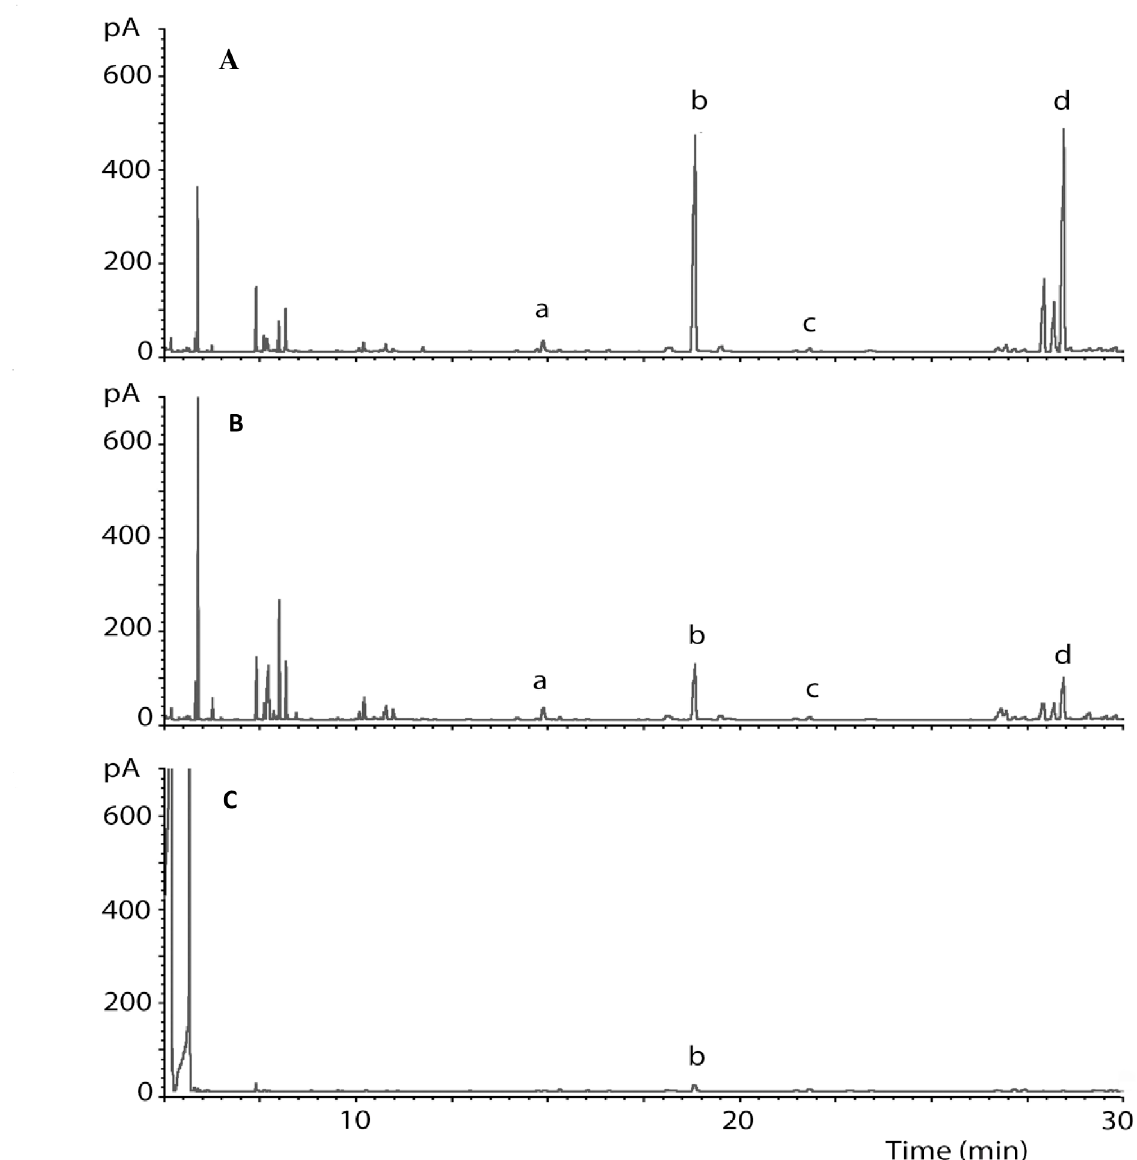
Fig 4. GC profiles of headspace volatiles from maize landrace, ‘ Nyamula ’ : ( A ) exposed to oviposition, ( B ) exposed to egg-induced maize volatiles from neighbouring plant, ( C ) unexposed. The identities of some of the EAG-activec ompounds whose emission was highly elevated by oviposition and induction are as follows: (a) limonene; (b) ( E )-4,8-dimethyl-1,3,7, nonatriene (DMNT); (c) methyl salicylate; (d)